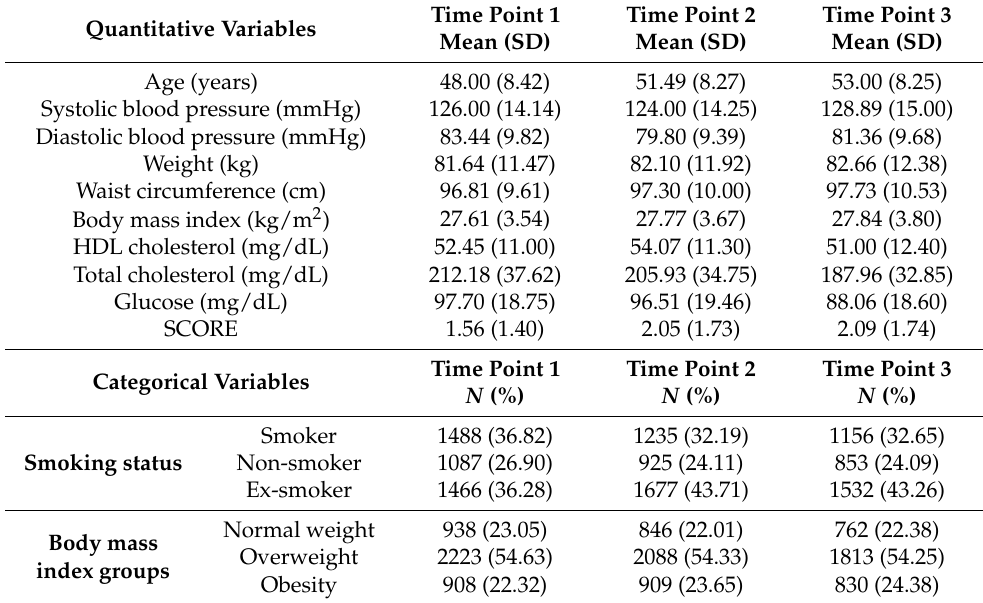
Table 2. Descriptive analysis of the study